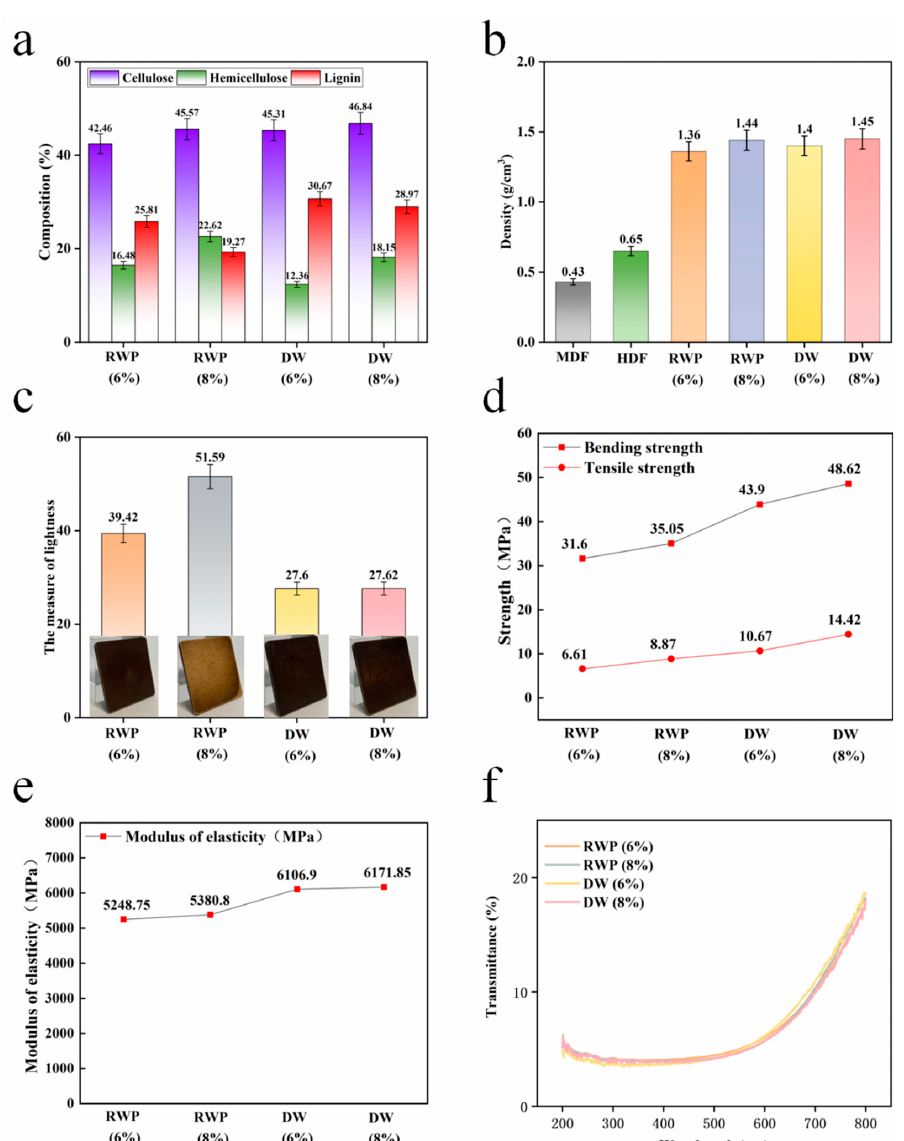
Figure 2. ( a ) Comparison of lignin, cellulose and hemicellulose content; ( b ) comparison of density; ( c ) comparison of brightness; ( d ) comparison of flexural strength and compressive strength; ( e ) comparison of modulus of elasticity; ( f ) comparison of UV transmittance.